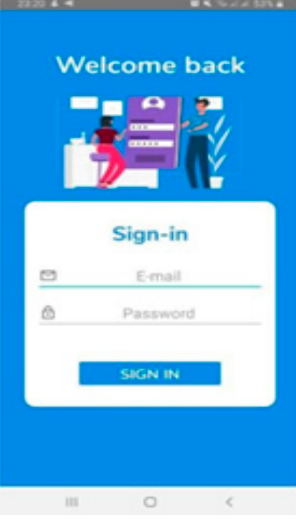
Figure 13. The sign interface.